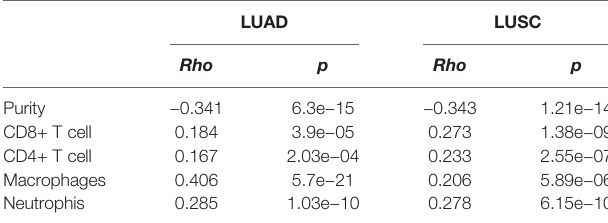
TABLE 1 | Correlation analysis between HEPH expression and immune in fi ltration level of the indicated immune cells. LUAD